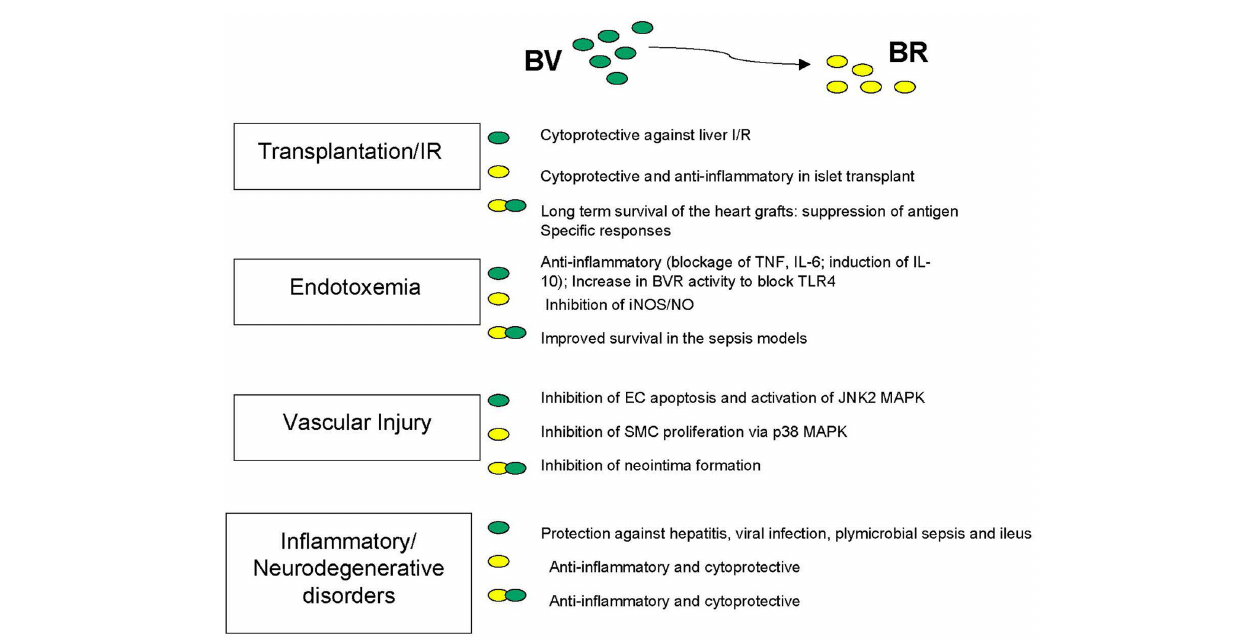
FIGURE 3 |The cytoprotective and anti-inflammatory role of BV and BR in the disease